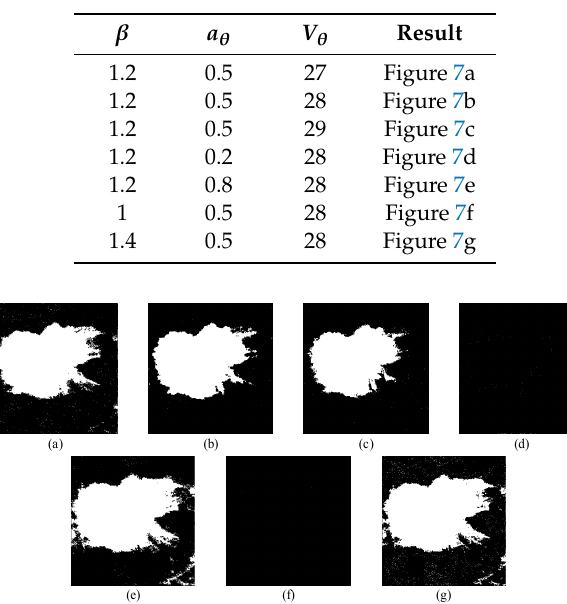
Figure 7. Detection results of different PCNN parameters. The result of each row in Table 3 is corresponding to the figure 7( a~g) below.